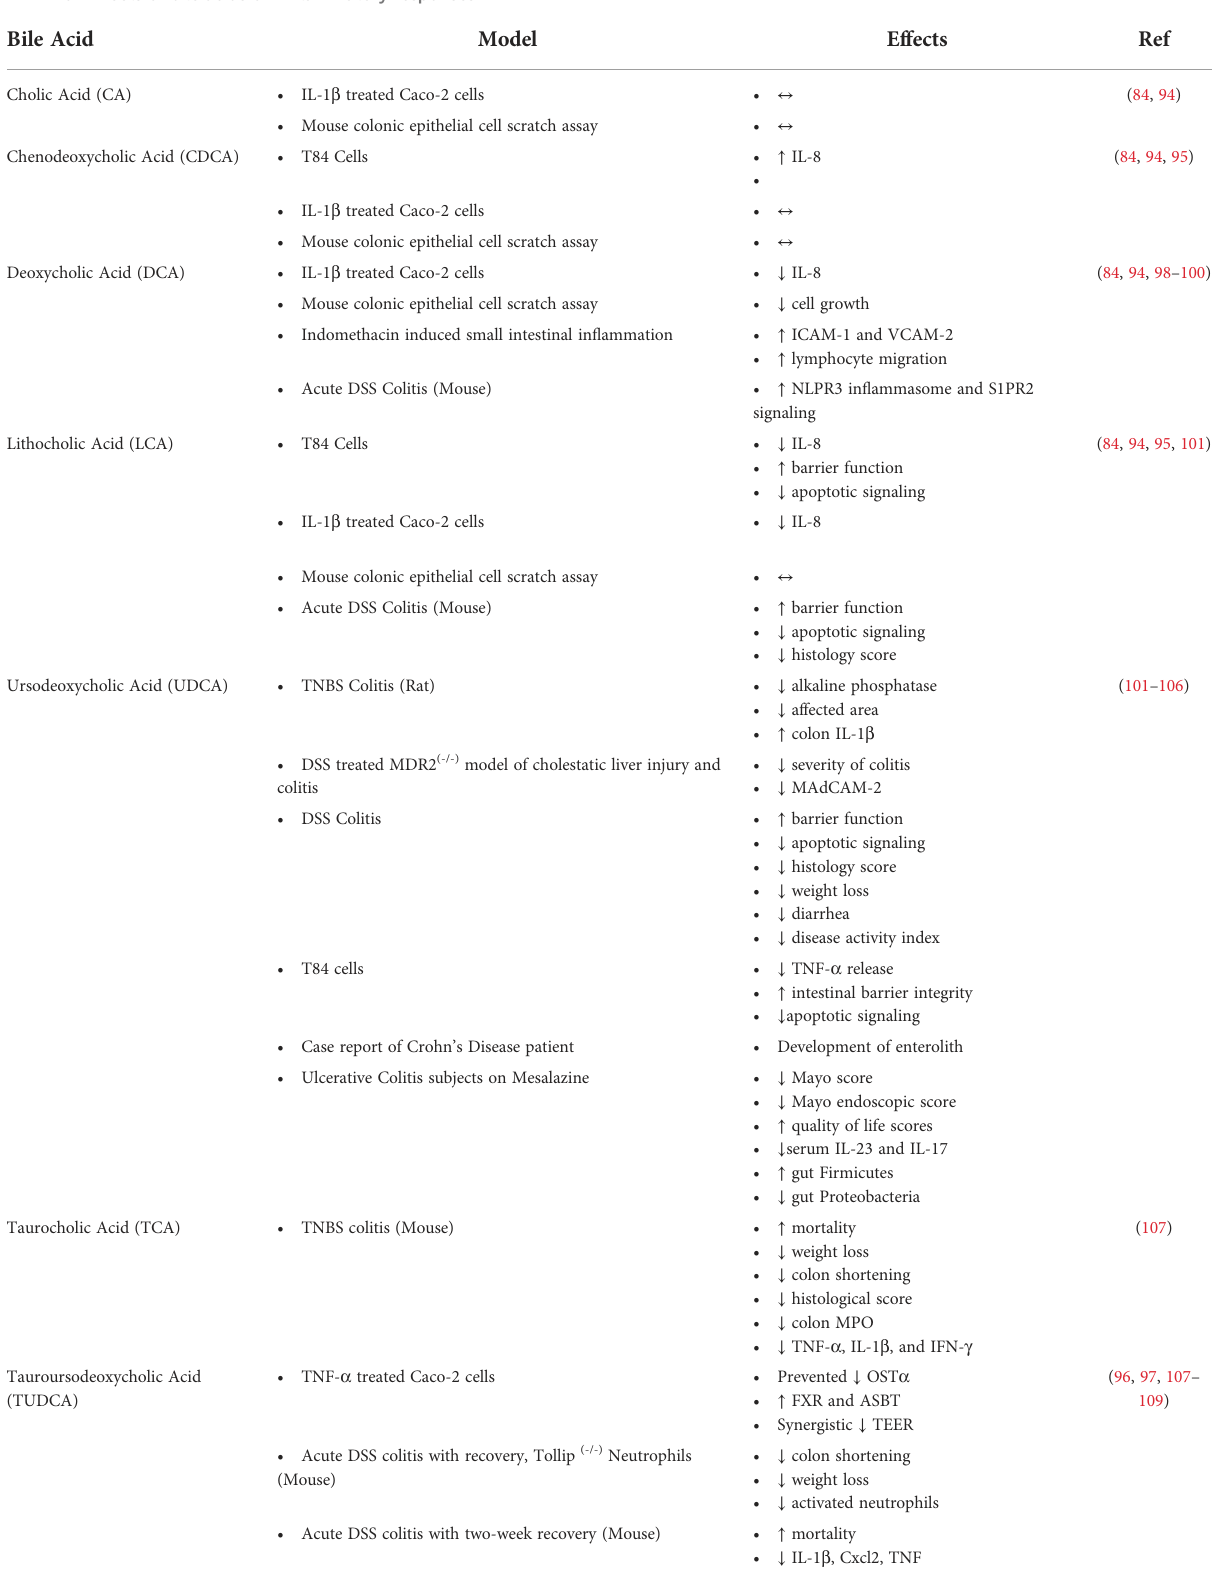
TABLE 3 Effects of bile acids on in fl ammatory